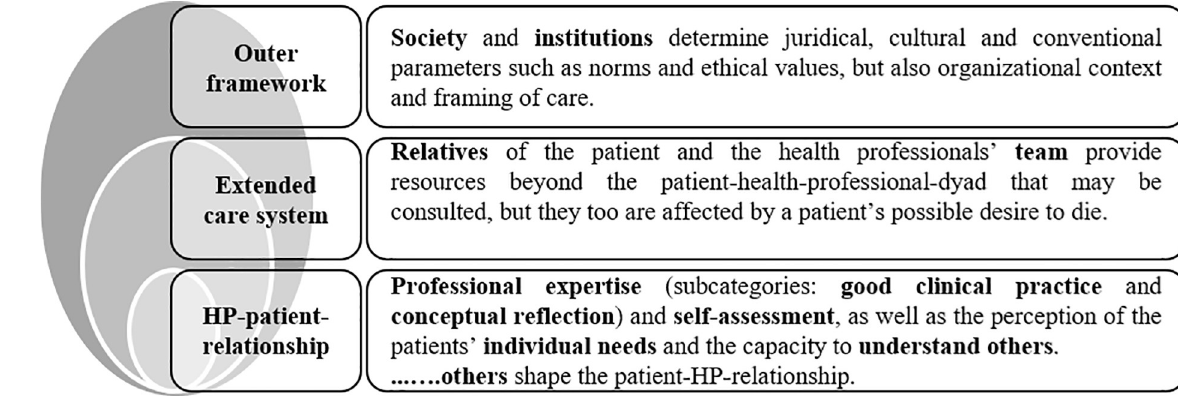
Fig 2. Thematic categories describing structures with an impact on dealing with desire to